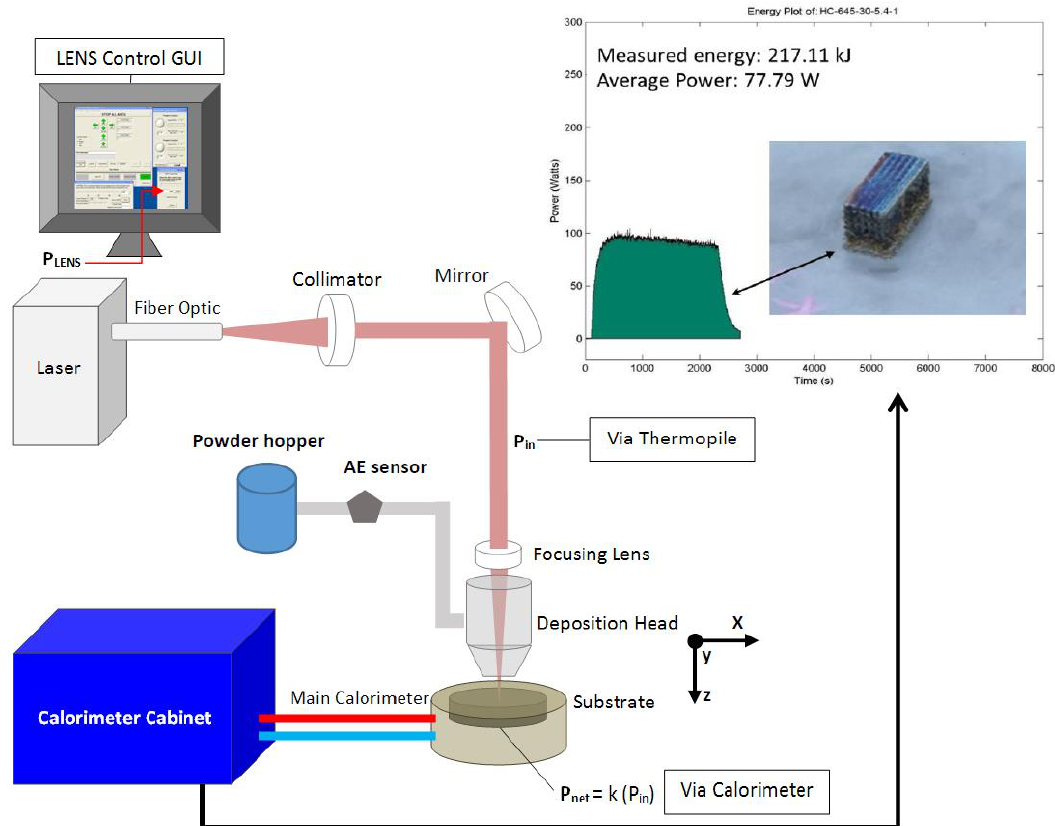
Figure 2. Schematic of LENS set-up with AE sensor for powder flow and power measurement calorimetric system (PMCS) utilized to monitor net heat input, among other things. Deposition head moves in x and y directoins and build plate moves in z direction. Top right is the output data from the power measurement calorimetric system (PMCS), which provides the integrated energy (kJ) as the sample is being built. This information provides a metric for future process